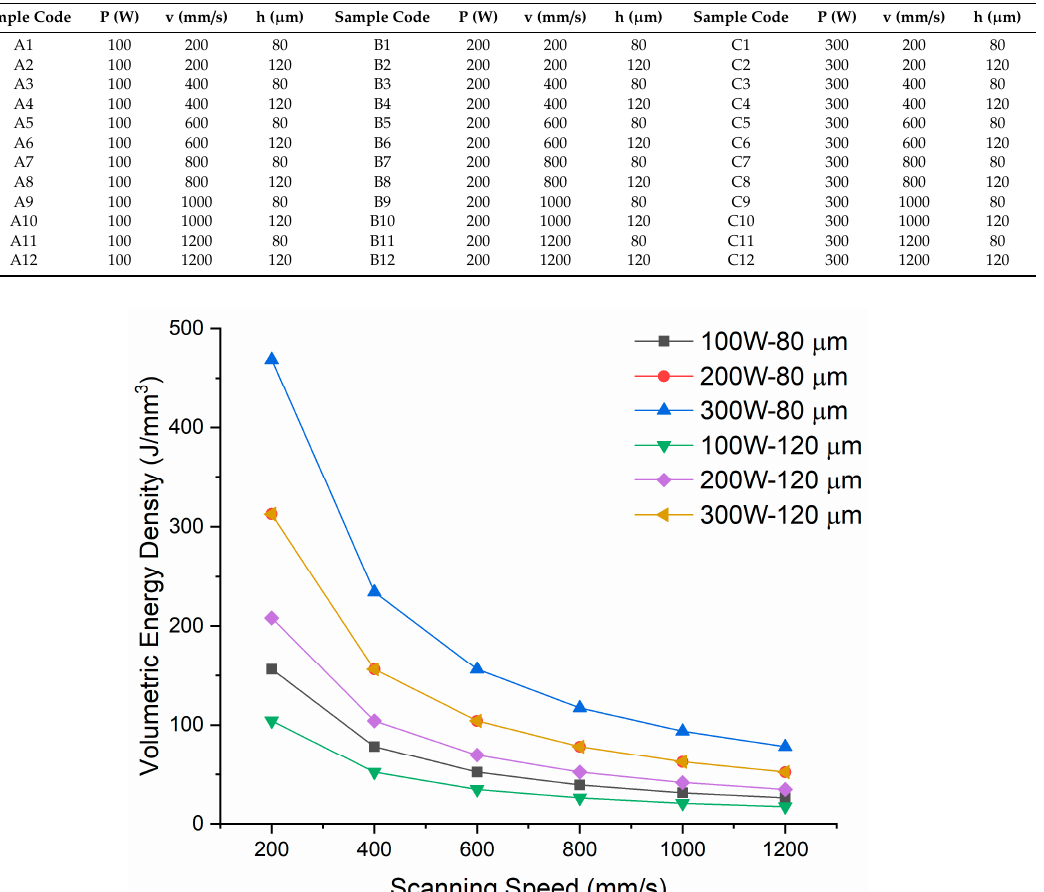
Figure 3. Volumetric energy density variation across the design matrix.